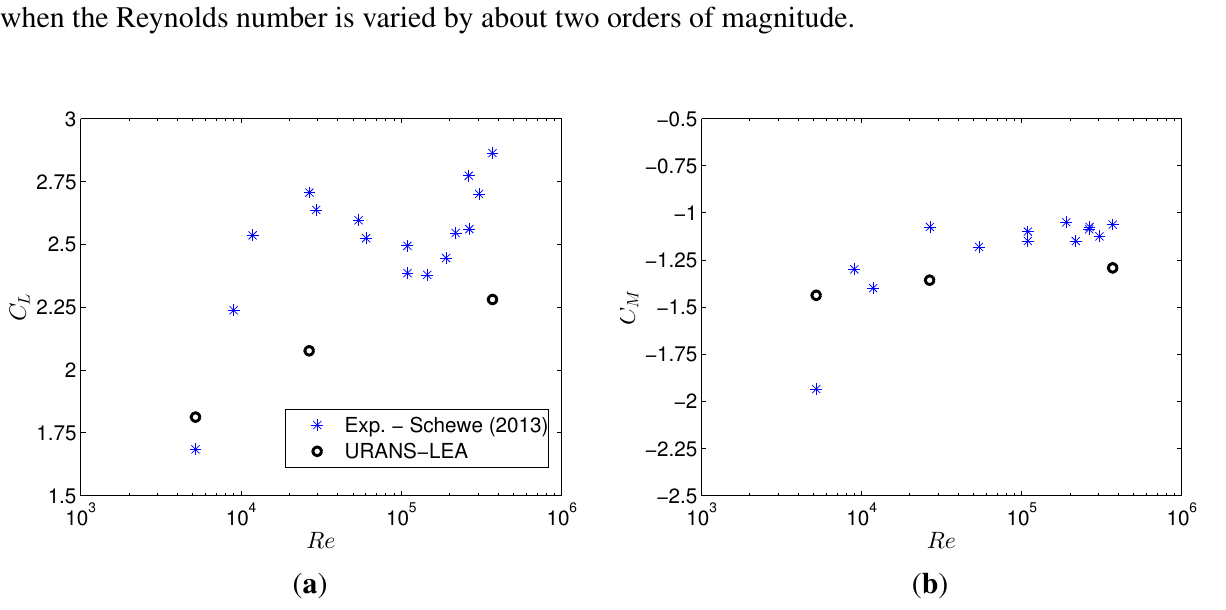
Figure 2. Mean lift ( a ) and moment ( b ) coefficients for the rectangular 5:1 cylinder at a 4 ◦ angle of attack vs . the Reynolds number: comparison of current numerical results and experimental data from